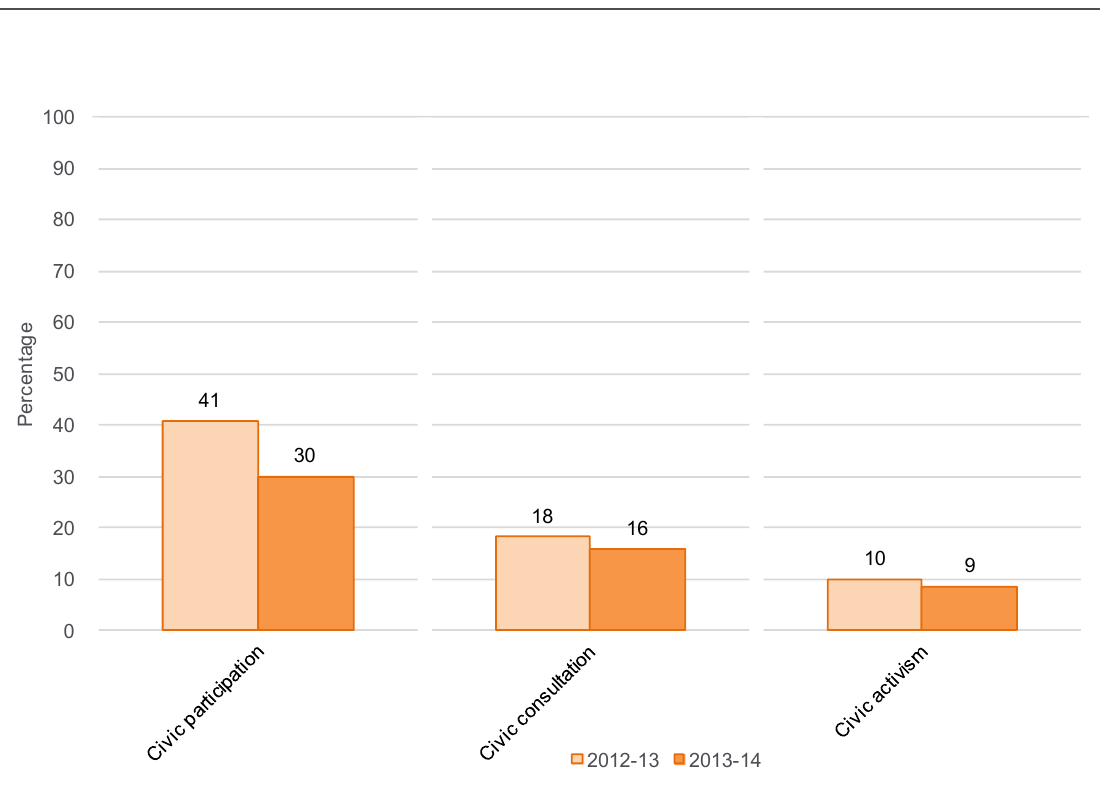
Figure 17: Whether people engaged in civic participation, civic consultation or civic activism at least once in the past 12 months, and at least once a month, 2012-13 to